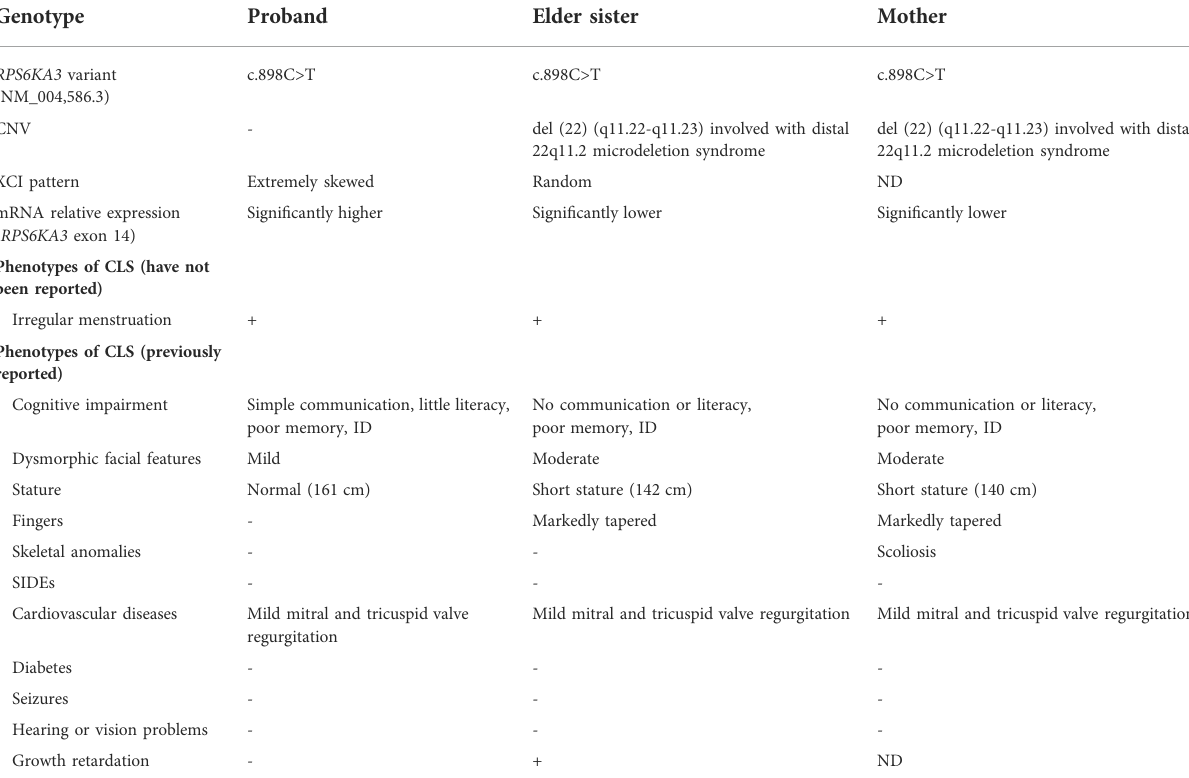
TABLE 1 Summary of genotype and phenotypes of the three female